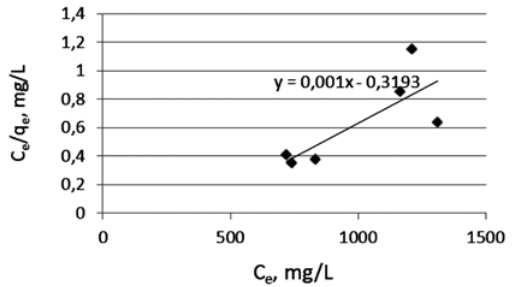
Fig. 3. Langmuir isotherm, when initial NH 4+ concentrations in the sludge liquid were in range between 1420–1720